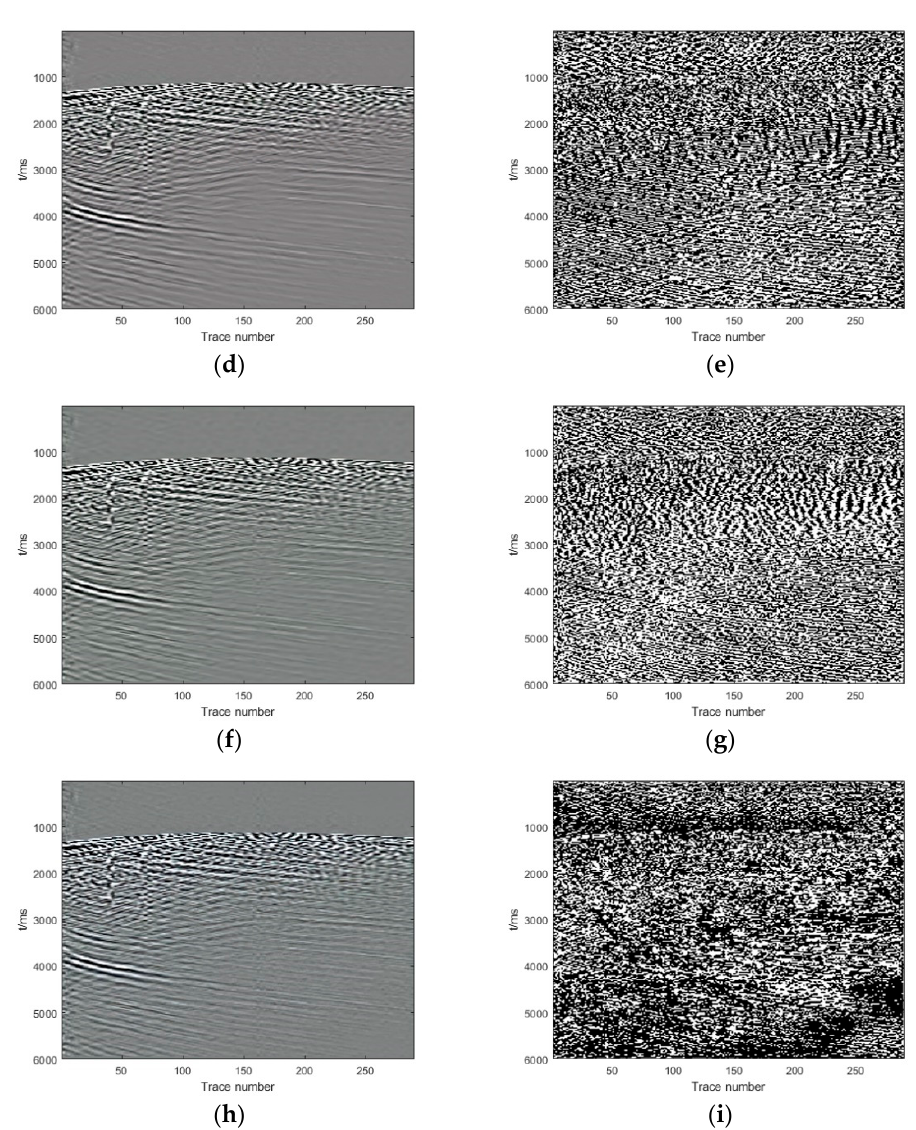
Figure 13. Denoising results of the fourth field example. ( a ) Noisy data; ( b ) Denoised image through the pre-trained model; ( c ) The difference profiles between noisy data ( a ) and pre-denoised data ( b ); ( d ) Denoised data through the proposed method; ( e ) The difference profiles between noisy data ( a ) and denoised data ( d ); ( f ) Denoised data through the DnCNN; ( g ) The difference profiles between noisy data ( a ) and denoised data ( f ); ( h ) Denoised data through the U-net; ( i ) The difference profiles between noisy data ( a ) and denoised data ( h ).